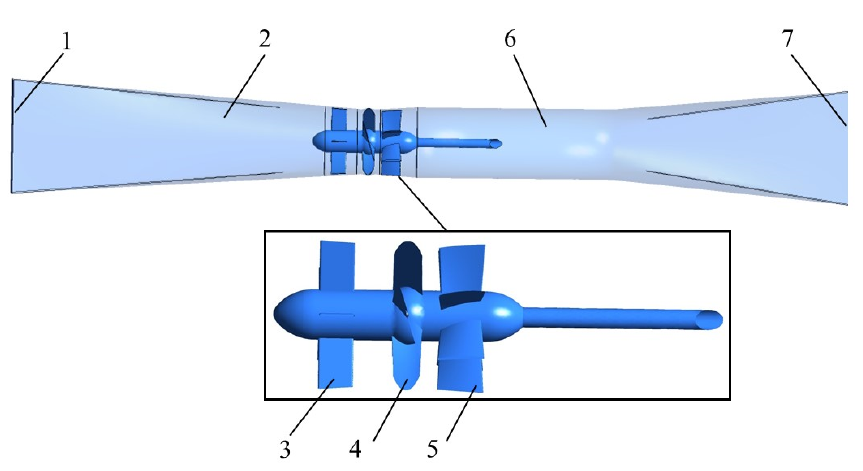
Figure 1. Flow channel diagram: 1—inlet; 2—inlet flow channel; 3—front guide vane; 4—runner; 5—guide vane; 6—outlet flow channel; 7—outlet. Table 1. Parameters of the axial-flow pump.